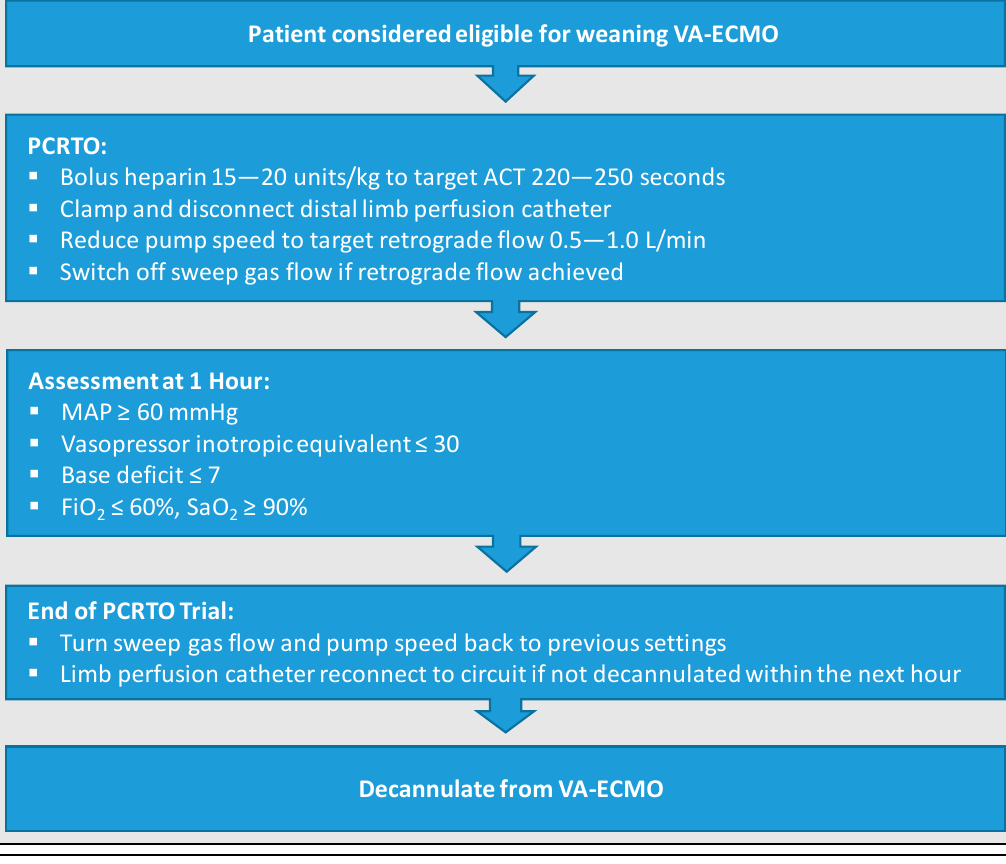
Figure 5. Standardized protocol for weaning from VA-ECMO according to Ling et al. [51]. PCRTO, Pump Controlled Retrograde Trial Off; ACT, activated clotting time; MAP, mean arterial pressure; FiO 2 , fraction of inspired oxygen; SaO 2 , arterial oxygen saturation.